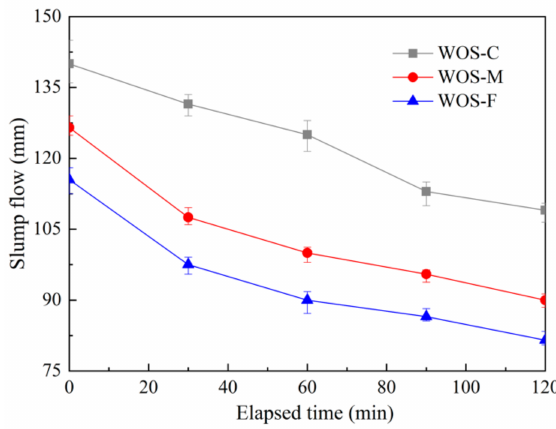
Figure 4. The effect of particle size of WOS on the initial slump